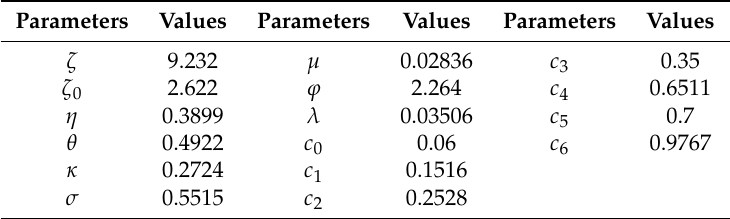
Table A4. Parameter values for the PWL OCV–SOC function in Equation (A3) without model mismatch. Same values are used with model mismatch except for c 3 = 0.34 and c 5 =